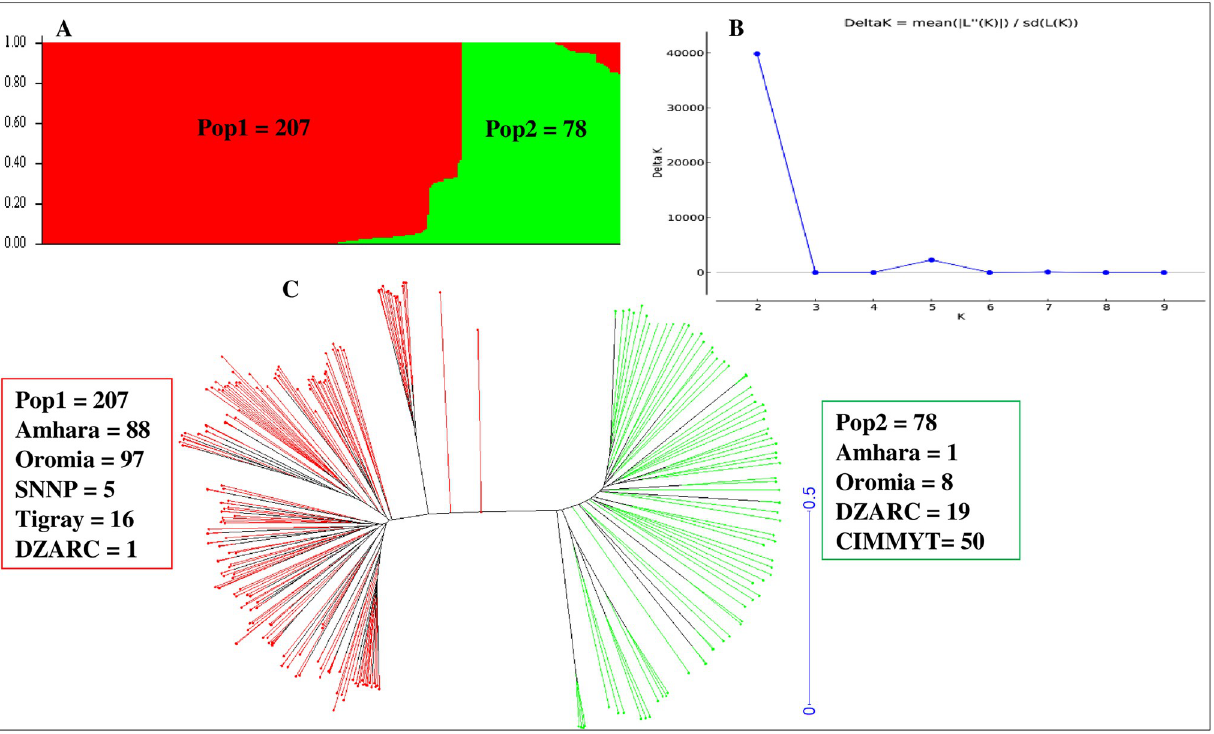
Fig 3. Population structure analysis of the durum wheat SP. (A) Bayesian structure analysis, (B) Structure harvester Evanno’s test Δ K at K = 2. (C) Neighbor Joining (NJ). Populations identified in STRUCTURE based on Bayesian structure analysis are shown in red and green for Pop1 and Pop2,